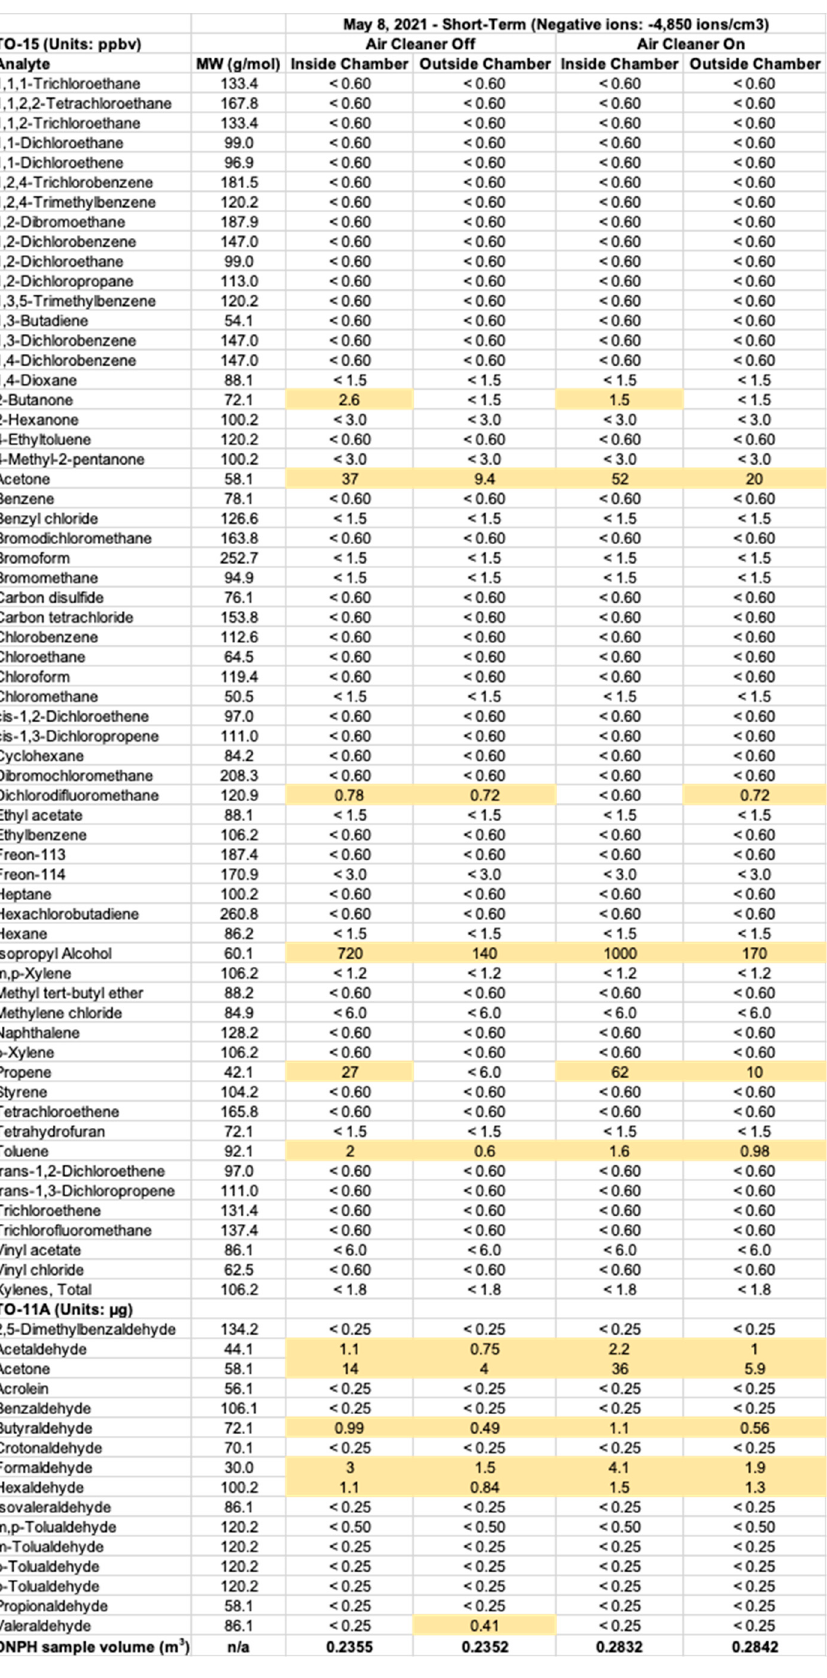
Figure A2. TO-15/TO-11A analytes and reported concentrations: 8 May 2021 short-term test.